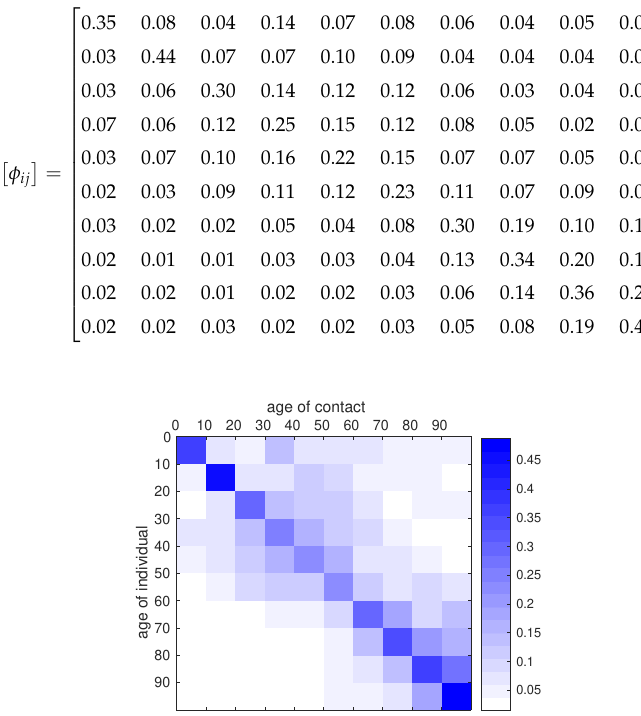
Figure 7. Graphical representation of the contact matrix φ . The intensity of blue in the cell ( i , j ) indicates the conditional probability that, given a contact between an individual of age group i and another individual, the latter belongs to the age class j . The matrix was reconstructed from the data of Prem et al. [21], with the method described in Appendix